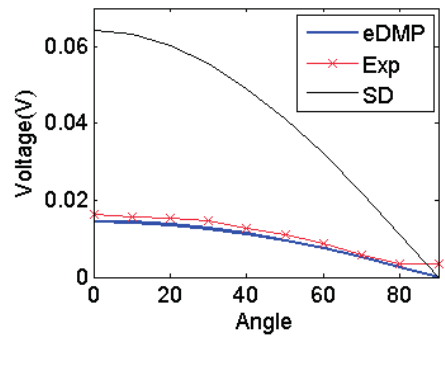
Figure 15. Simulation results comparison.